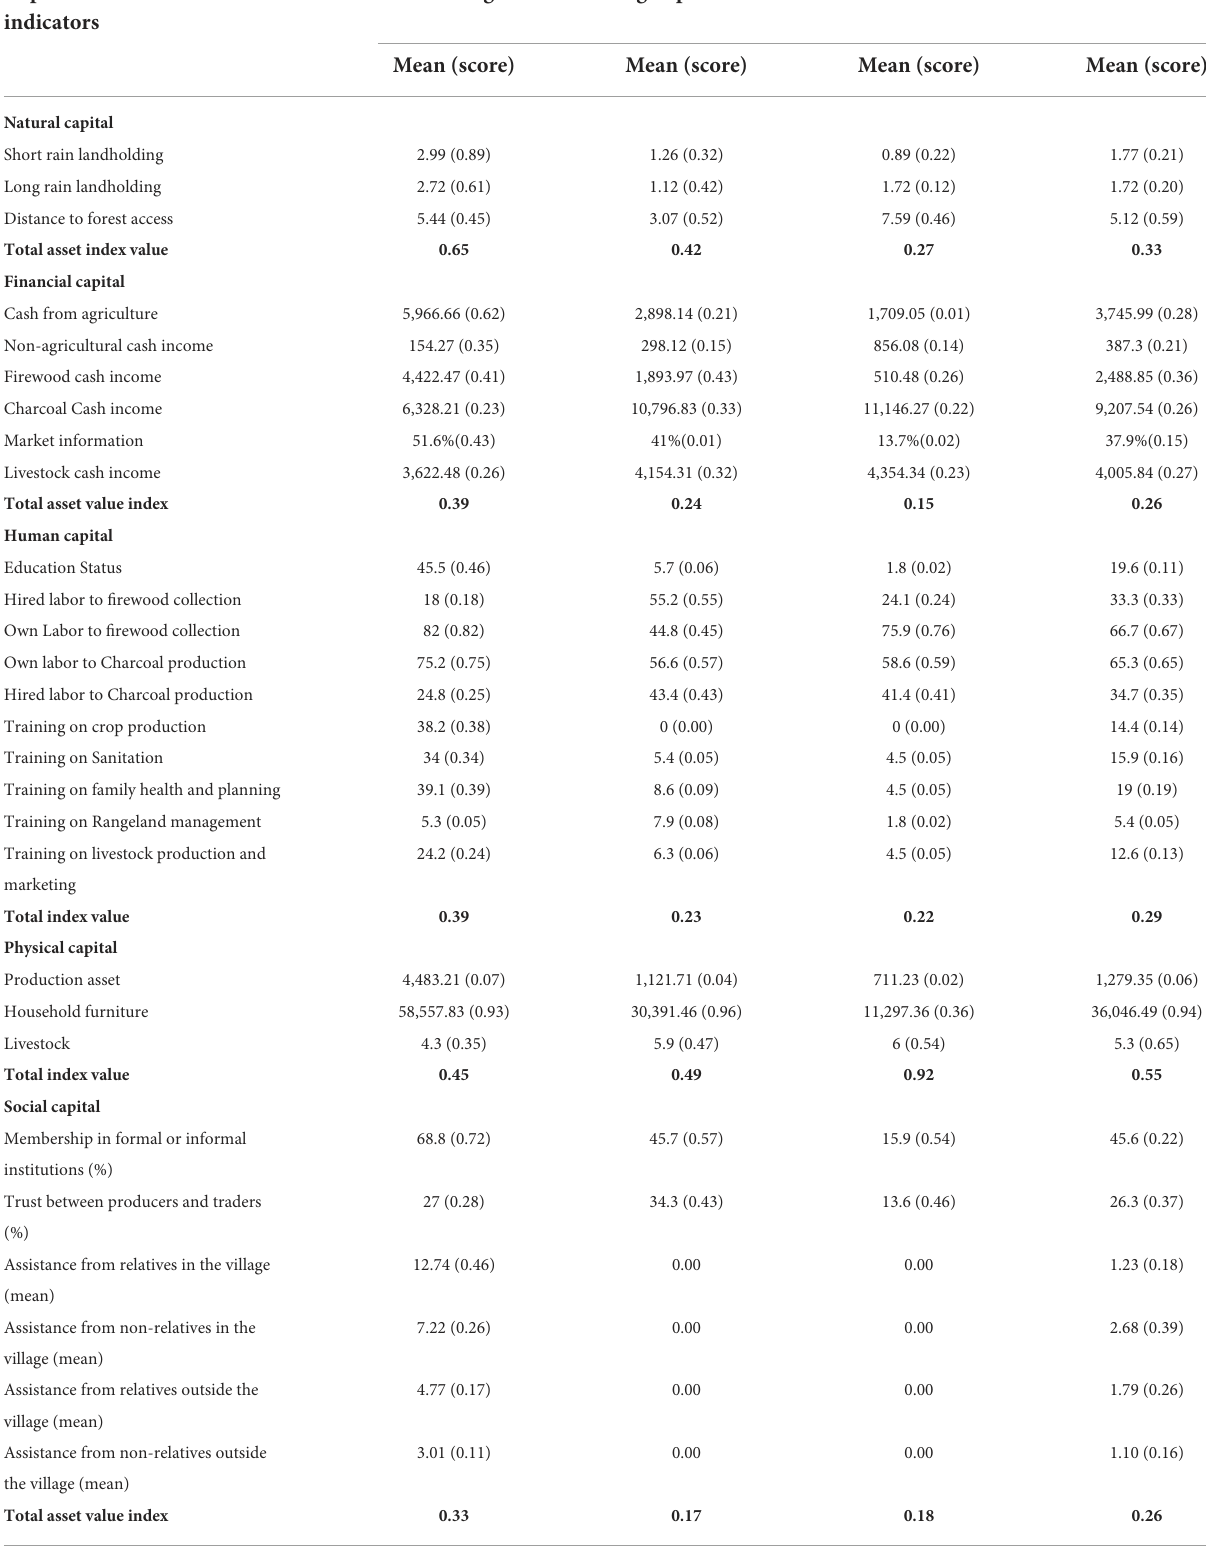
TABLE 4 The status of livelihood capital across livelihood groups. Capital sources and